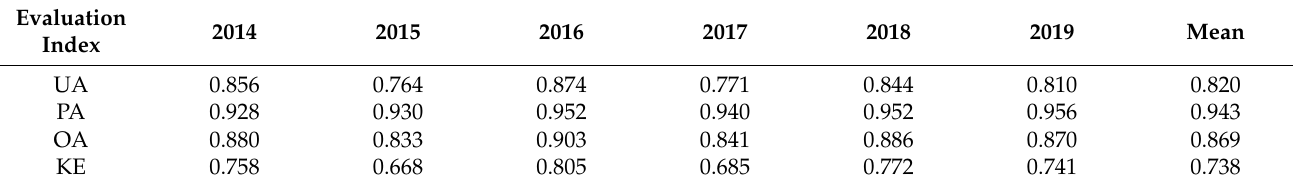
Table 2. The evaluation index derived from the confusion matrix from 2014 to